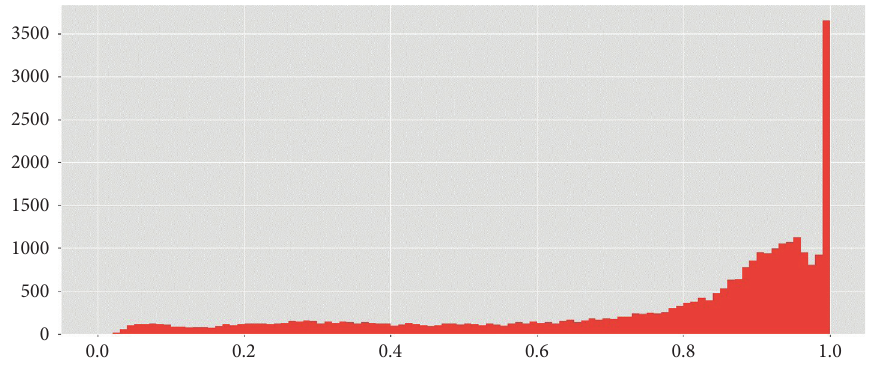
Figure 7: Distribution of load factor data.